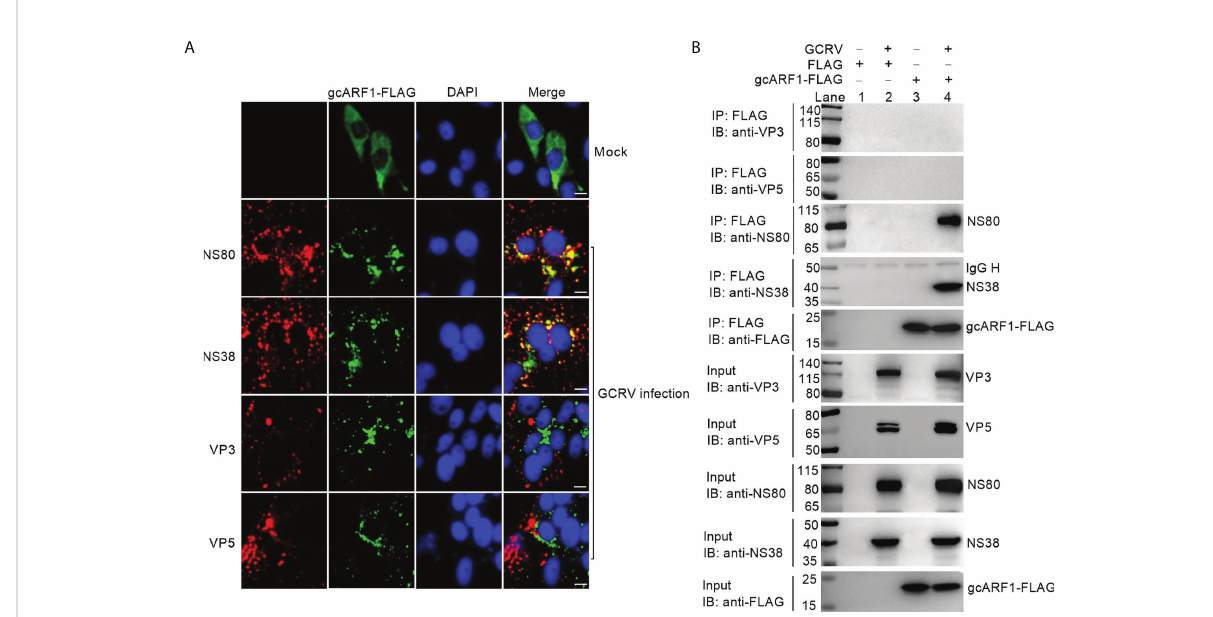
FIGURE 2 The subcellular co-localizations or interactions between gcARF1 and GCRV proteins. (A) The subcellular co-localizations between gcARF1 and GCRV proteins. CIK cells plated onto coverslips in 24-well plates were transfected with FLAG-tagged gcARF1. Then the cells were infected with the GCRV at an MOI of 1 or left untreated for another 24 h. Finally, the cells were washed and fi xed with 4% PFA for immuno fl uorescence assays. The images were obtained by Leica confocal microscopy. Scale bars, 10 µm. (B) The interactions between gcARF1 and NS80, NS38, VP3 or VP5. CIK cells seeded in 10-cm 2 dishes were transfected with indicated plasmids. After 24 h later, the cells were infected with the GCRV at an MOI of 1 or left untreated for another 24 h. Finally, the cells were harvested and used for protein extraction. Co-IP was performed with anti- FLAG-conjugated agarose beads. The cell lysates and bound proteins were analyzed by immunoblotting with the indicated